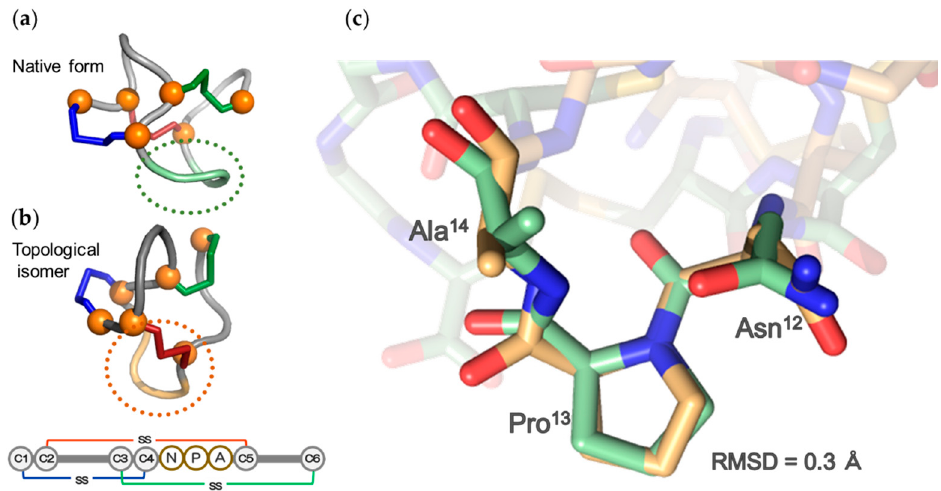
Figure 5. The receptor binding site (-Asn-Pro-Ala-) of ST a was shown in ( a ) the native form and ( b ) topological isomer illustrated by light green and light orange , respectively. ( c ) The superposition of the receptor binding site of the native form and the topological isomer.